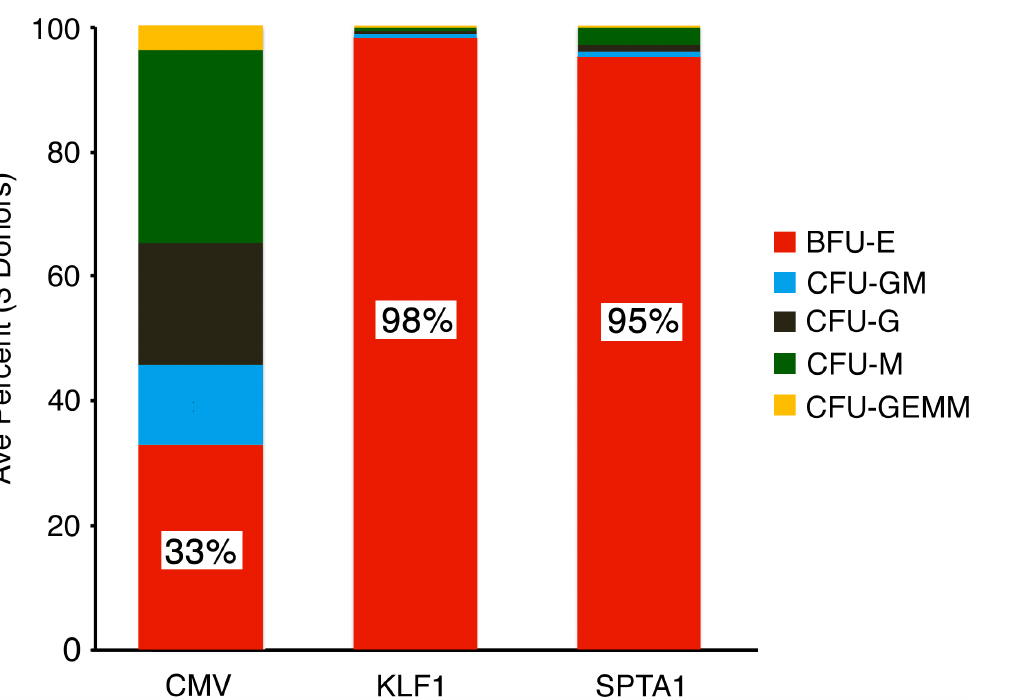
Fig 1. Erythroid-specific over-expression of LIN28A confirmed by colony formation assays. Cells were transduced with lentivirus particles for LIN28A over-expression driven by a CMV, KLF1, or SPTA1 promoter (See Methods). Transduced cells were cultured for 14 days in semi-solid methylcellulose medium supplemented with puromycin. Average colony counts were obtained from duplicate wells of each condition (three separate donors). The average percentage of each colony type is shown as separate colors (BFU-E percentage shown in red bar field; color key on the